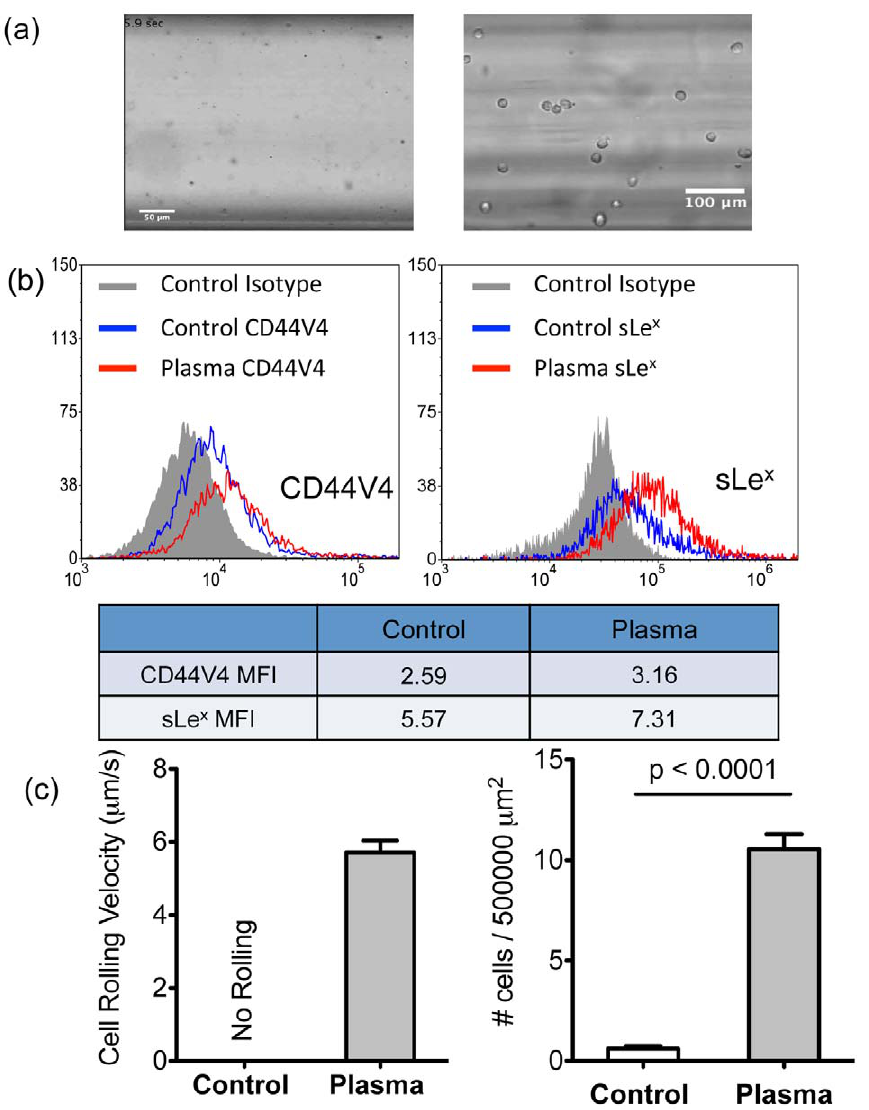
Figure 1. Plasma triggers an adhesive phenotypic switch of breast cancer ( BCa ) cells on E-selectin coated surface under flow. (a) Left: Untreated MDA-MB-231 cells (2-D culture with regular medium) show no interactions with the E-selectin coated surfaces under flow. Right: Cells establish stable rolling on E-selectin coated surface after 48 h plasma treatment. (b) Flow cytometry results of CD44V4 (left) and sLe x (right) expression on untreated and plasma treated MDA-MB-231 cell surfaces. Mean fluorescence intensity ratio of sample over isotype has been included. (c) Left: Average rolling velocity of untreated (control) and plasma treated MDA-MB-231 cells (n=35 cells). Shear stress of 1 dyn/cm 2 was used. Right: Average numbers of cells interacting with the E-selectin coated surface per 5 6 10 5 m m 2 of untreated (n=30 frames) and plasma treated (n=36 frames) MDA-MB-231 cells. Bars represent mean 6 SEM. P , 0.0001, two-tailed unpaired student t-test.